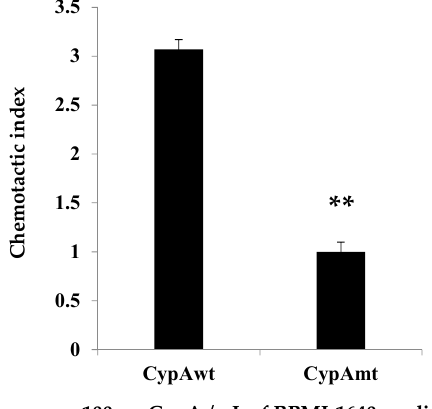
Figure 4. The chemotactic activity of recombinant CypA protein. The figure shows the comparative chemotactic activity of CypA wt (wild type) and CypA mt (mutant type) (100 µg/mL) of yellow catfish for head kidney leucocytes of yellow catfish. Data are expressed as the means ± SD, ( n = 3) of three fish. The bar with “**” is highly significantly different ( p < 0.01).